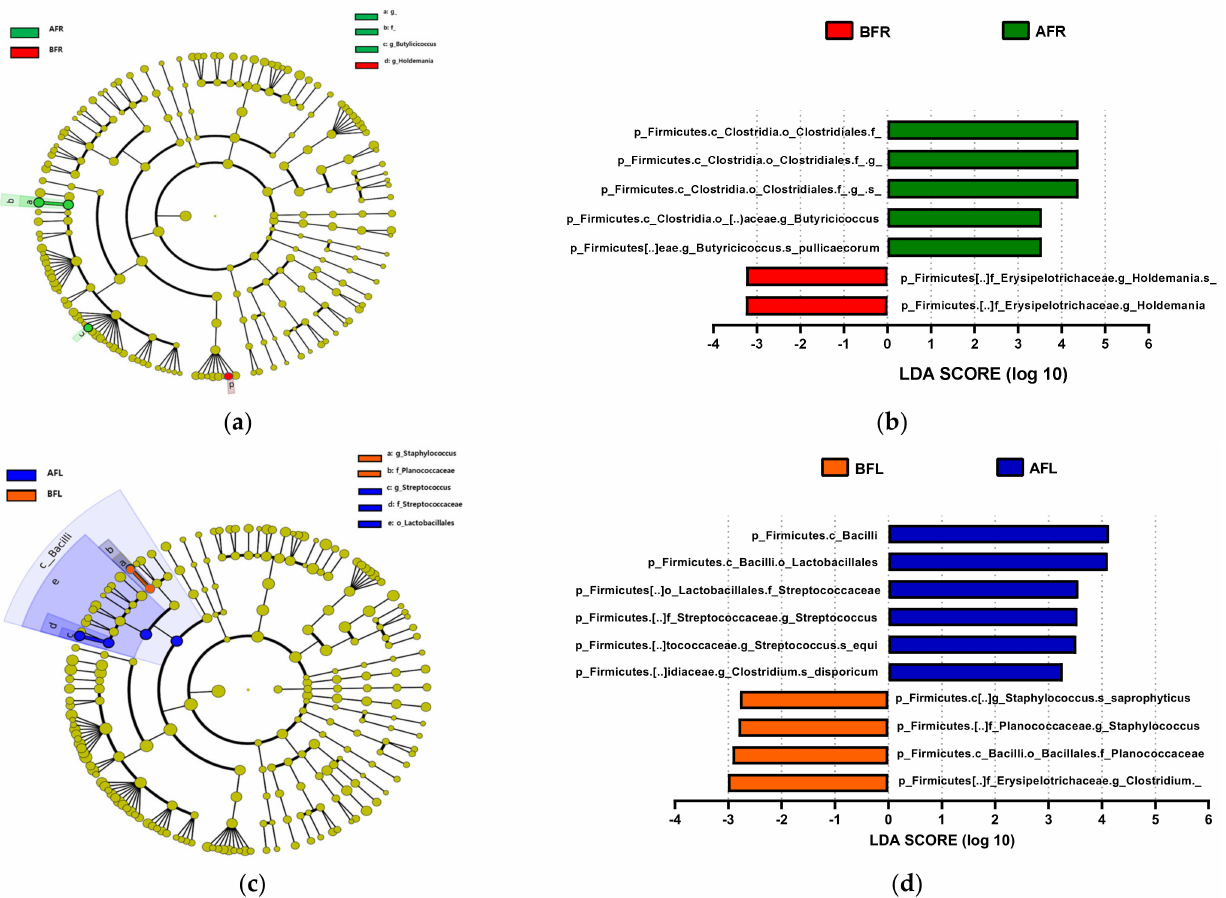
Figure 5. Differences between the taxonomic composition of before and after flavonoid-rich orange juice group and flavonoid-low orange cordial group intervention in depression. Lefse ( a , c ) and LDA analysis score ( b , d ) show the difference in abundance of bacterial taxa between before and after intervention with flavonoid-rich orange juice groups. BFR: Before flavonoid-rich orange juice group, AFR: after flavonoid-rich orange juice group, BFL: before flavonoid-low orange cordial group, AFL: after flavonoid-low orange cordial